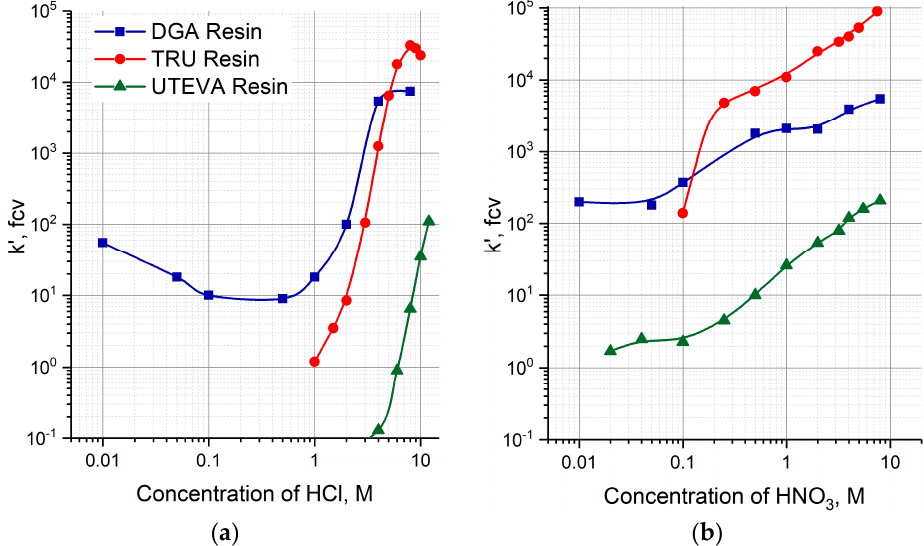
Figure 3. Capacity factors k ’, fcv, of Th(IV) on DGA, TRU and UTEVA resins as a function of HCl ( a ) and HNO 3 ( b ) concentrations [37–39].